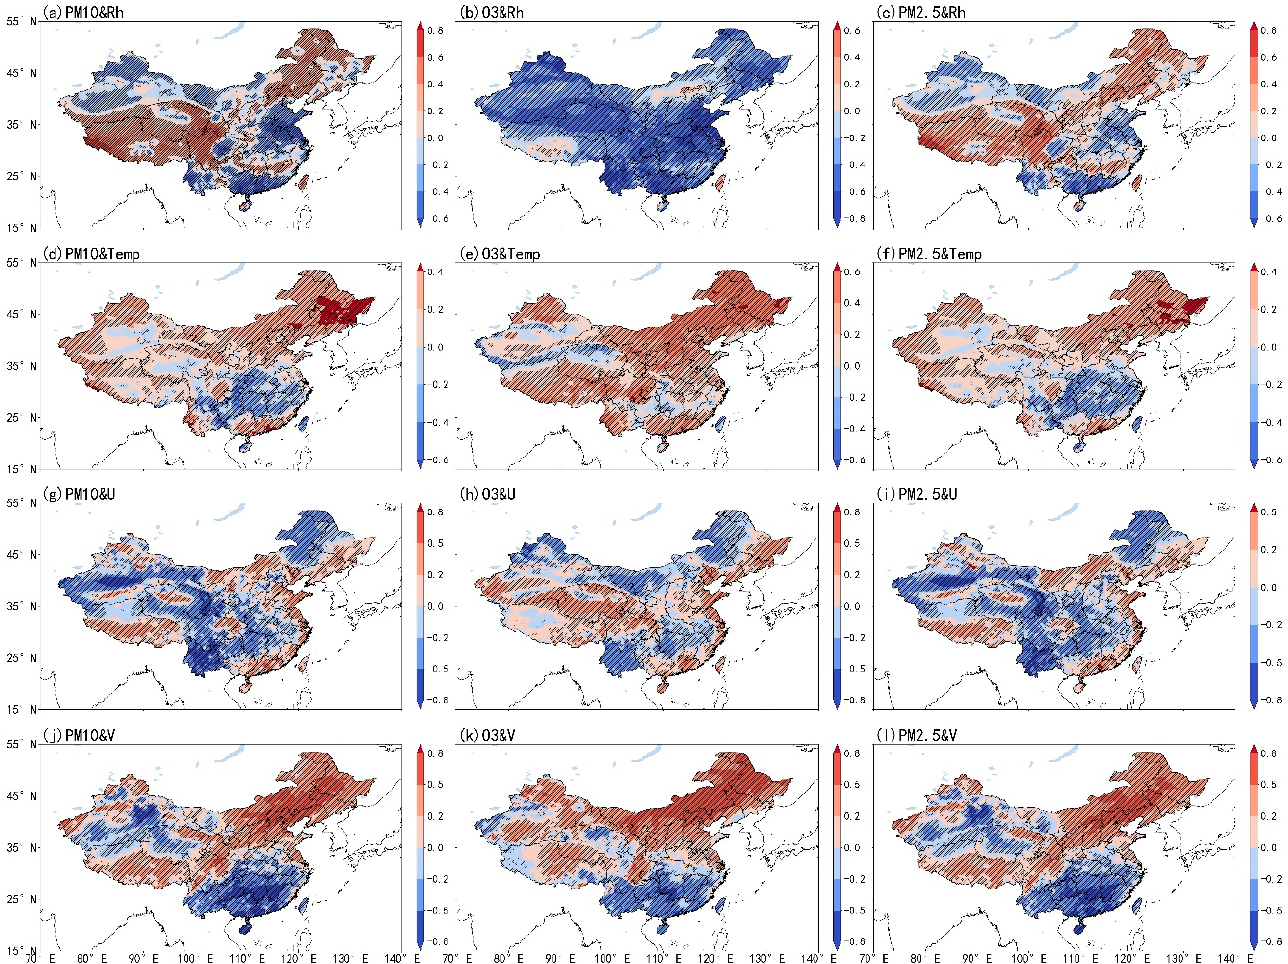
Figure 14. Correlation coefficients between surface pollutants and corresponding surface meteorological variables in summer from 2013 to 2018. ( a ) PM 10 and humidity, ( d ) PM 10 and temperature, ( g ) PM 10 and zonal wind and ( j ) PM 10 and meridional wind. ( b ) O 3 and humidity, ( e ) O 3 and temperature, ( h ) O 3 and zonal wind and ( k ) O 3 and meridional wind. ( c ) PM 2.5 and humidity, ( f ) PM 2.5 and temperature, ( i ) PM 2.5 and zonal wind and ( l ) PM 2.5 and meridional wind. The slashes indicate that the results passed the 95% Monte Carlo correlation